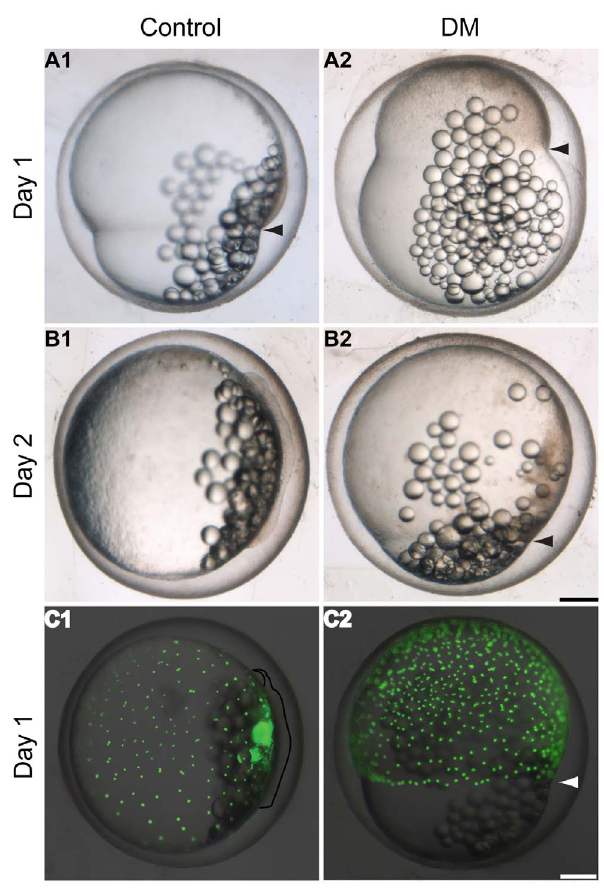
Figure 2. Bmp inhibition delays epiboly progression in K. marmoratus . Epiboly coverage was recorded at day 1 ( A ) and day 2 ( B ) post-fertilization (dpf) in embryos exposed to 100 m M dorsomorphin (DM) at the 32-cell stage. Progression of the yolk syncytial layer (YSL) during gastrulation was assessed via staining of yolk syncytial nuclei (YSN) using Sytox Green. The green fluorescent YSN were observed 1 dpf ( C ). A1, 2 : As control embryos reach c. 70% epiboly ( A1 arrowhead, n=10/10), DM treated embryos are delayed with epiboly covering c. 30% of the yolk ( A2 arrowhead, n=10/10). B1, 2 : Controls reach the otic vesicle formation stage ( B1, n=10/10) whilst exposed embryos are lagging behind around 90% epiboly ( B2 arrowhead, n=10/10). C1 , 2 : Shortly after epiboly closure, control embryos enter the eye formation stage ( C1, n=10/10) (embryo and the eye are outlined) and YSN are spread all over the yolk. On the other hand DM exposed embryos are still mid-epiboly and fluorescent YSN are observed near the blastoderm margin ( C2 arrowhead, n=10/10), demonstrating that YSN are also delayed by inhibition of Bmp signalling. All images are lateral views of the embryos. Scale bars: 250 m m.